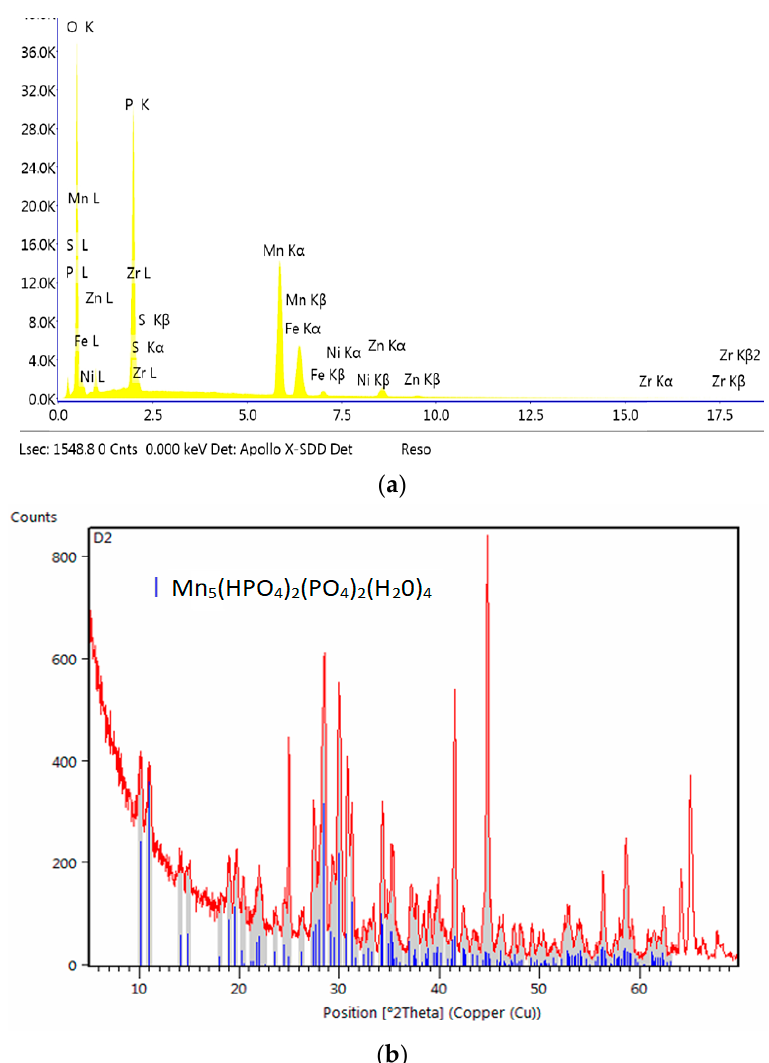
Figure 12. EDS ( a ) and XRD spectra ( b ) of the sample modified with zinc.